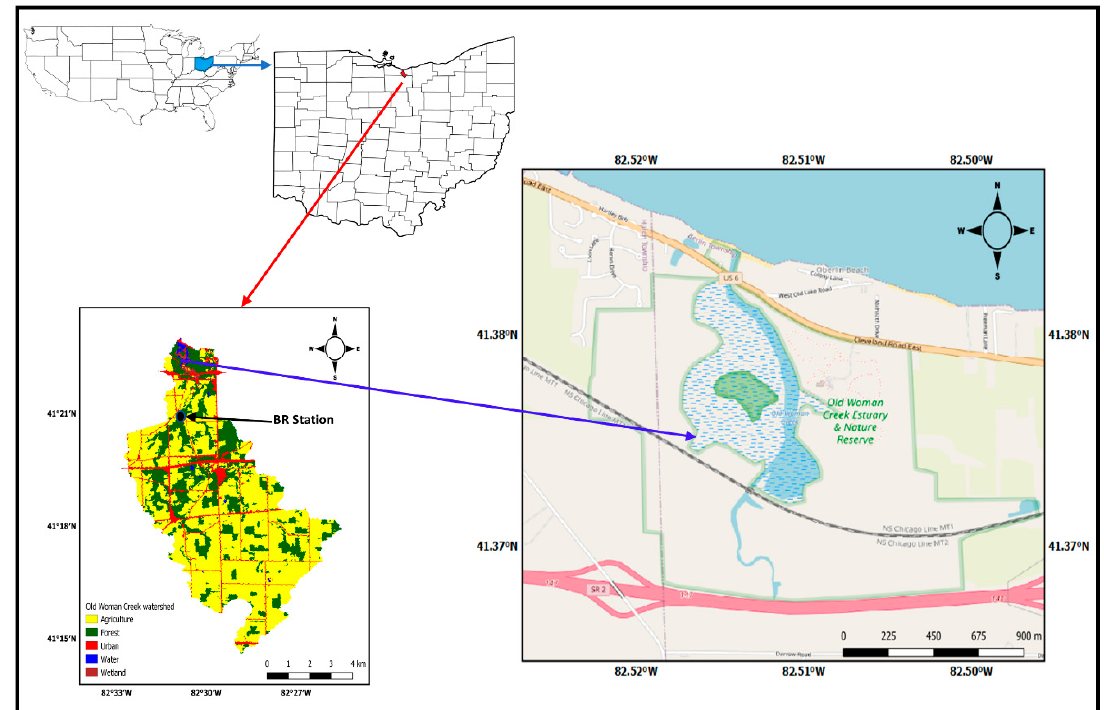
Figure 1. Location map of the Old Woman Creek watershed and estuary, Ohio.